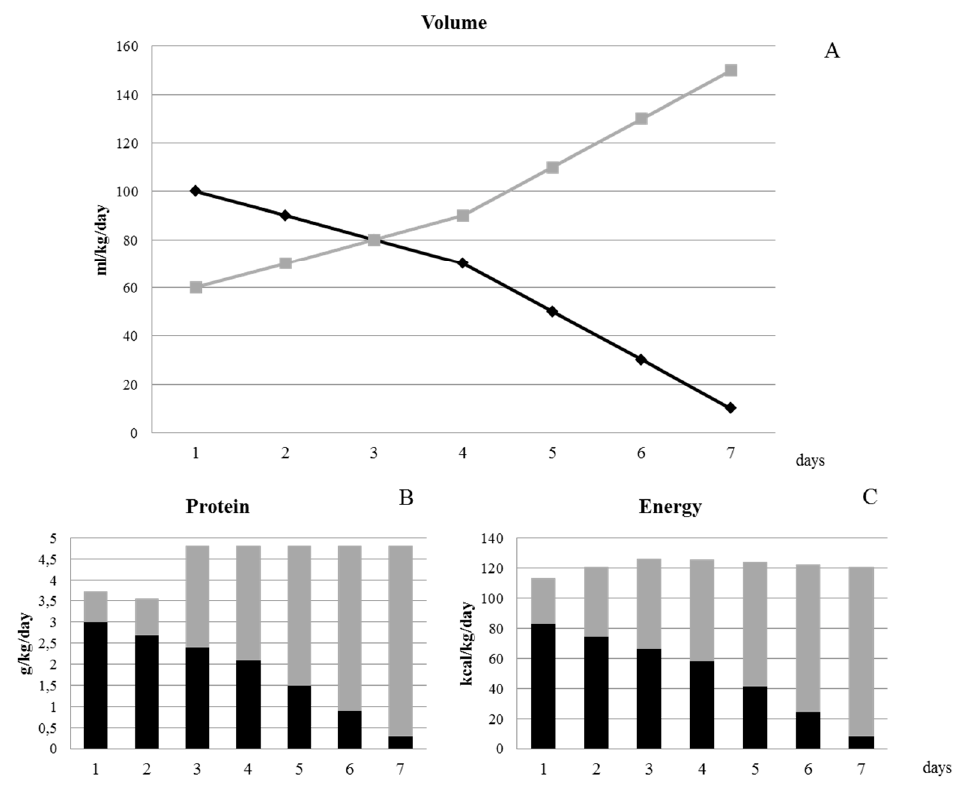
Figure 2. Protocol of weaning from parenteral nutrition. ( A ) The figure shows the progression of the decrease of parenteral nutrition (PN) (black line) and increase of enteral nutrition (light grey line) in terms of volume (mL / kg / day). Figure ( B ) and figure ( C ) show, respectively, the daily protein intakes (g / kg / day) and daily energy intakes (kcal / kg / day) administered by the standard PN bag (black bar) and by enteral nutrition (light grey bar).